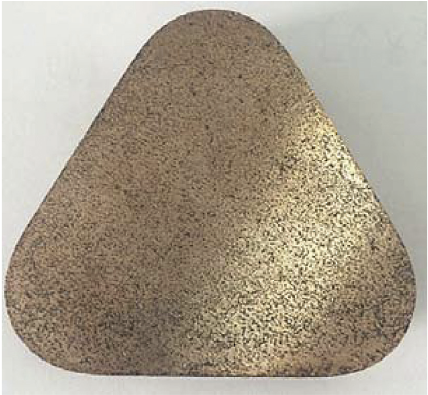
Figure 3: Surface of the brake pad after grinding.